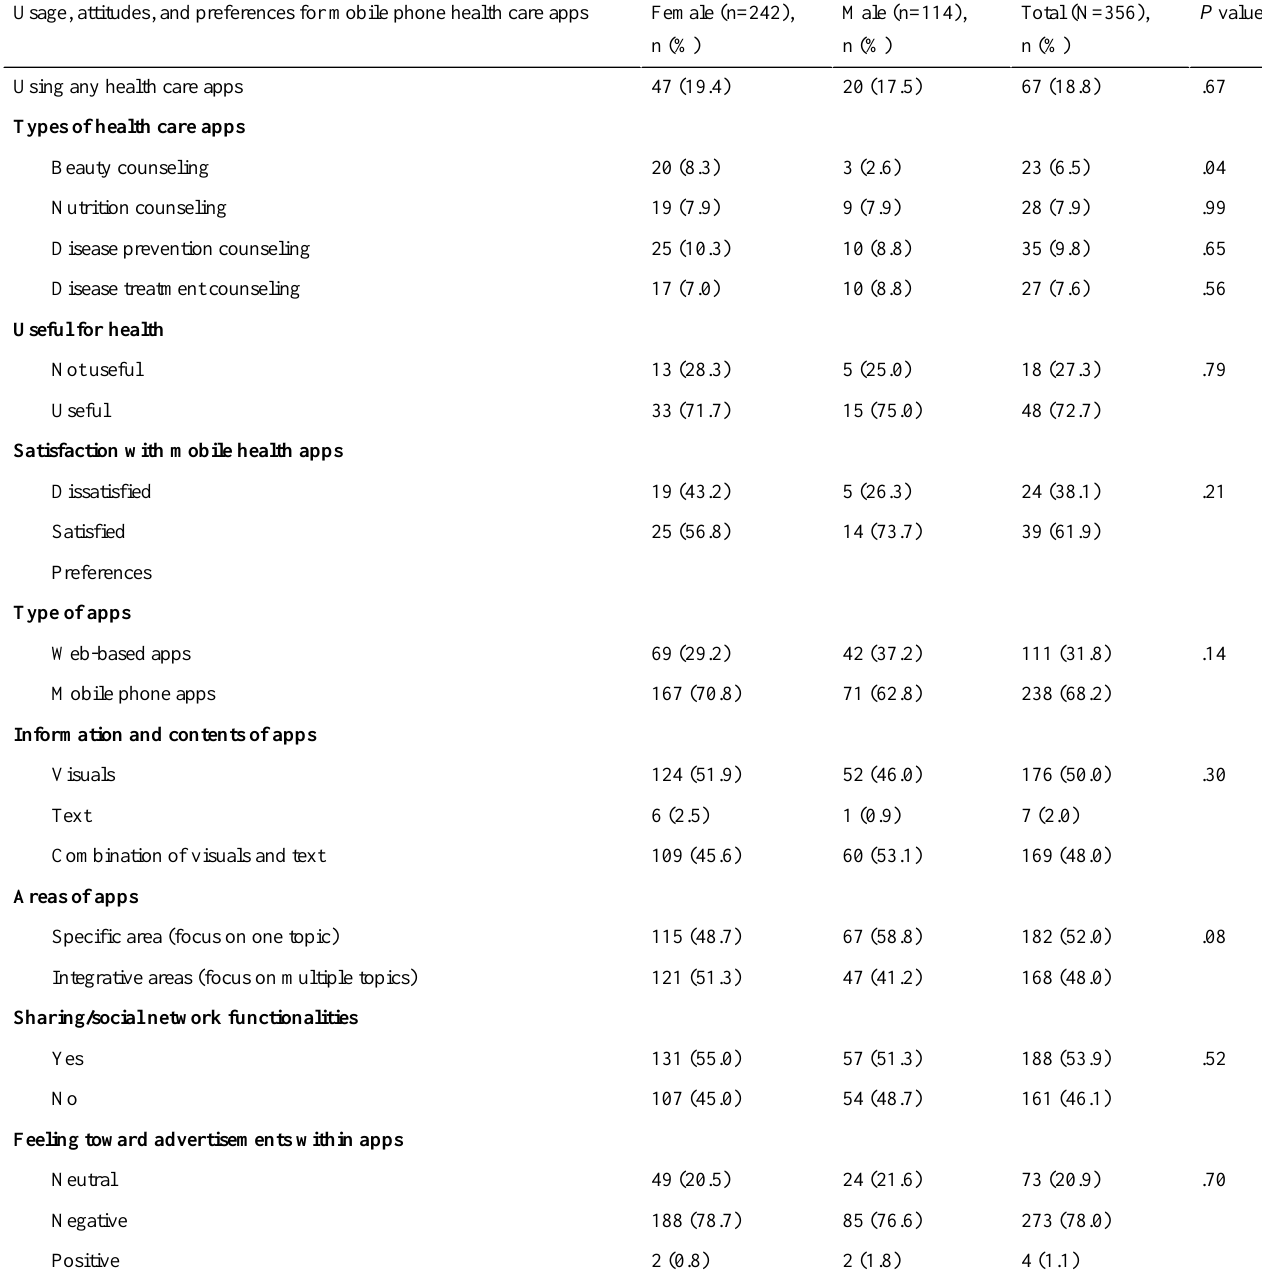
Table 3. Usage, attitudes, and preferences for mobile phone health care apps.